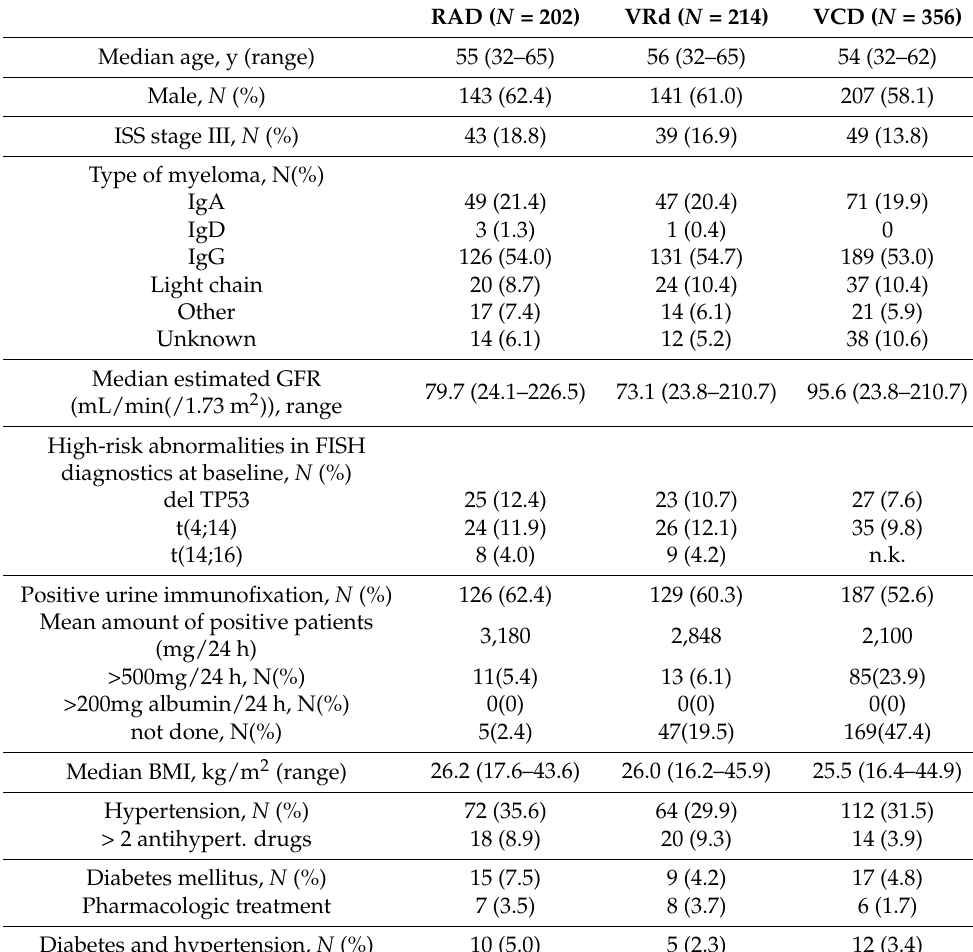
Table 1. Baseline